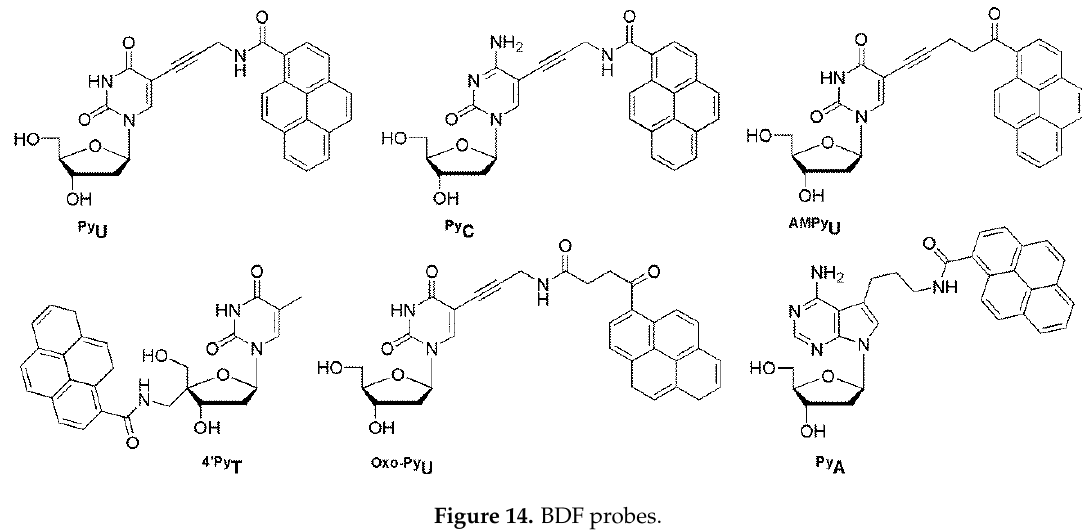
Figure 14. BDF probes.